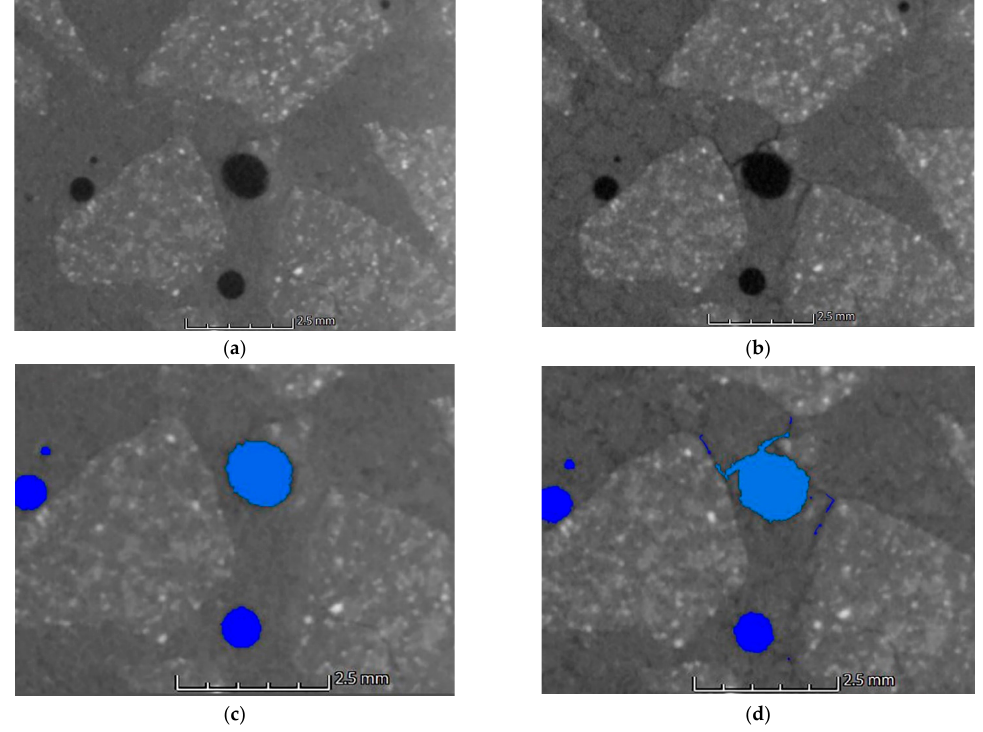
Figure 16. Porosity of HPFRC 1.1 sample heating to 600 °C: ( a ) before heating; ( b ) after heating; ( c ) graphical result of analysis before heating; ( d ) graphical result of analysis after heating.